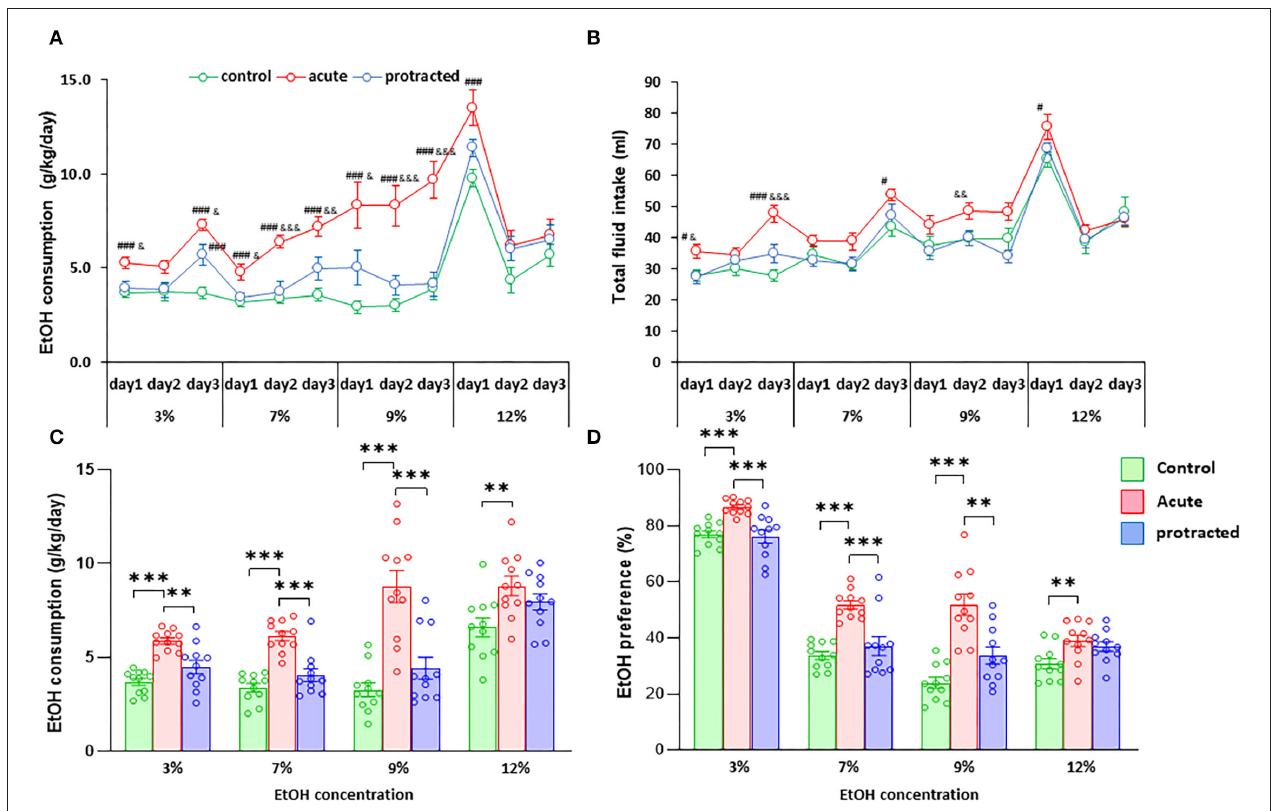
FIGURE 4 | Protracted and acute prenatal stress-evoked excessive ethanol intake in young adult female offspring at age of PND70. Ethanol drinking behavior was measured using two-bottle free-choice test. In (A,C) , a daily and means of 3-day ethanol consumption at given concentrations with corresponding control groups shows that male rats born from dams subjected to either protracted or acute stress developed significantly high ethanol consumption and preference (D) characterized by excessive ethanol intake (g/kg/day) to all four concentrations of ethanol provided and less water intake. * p < 0.05, ** p < 0.01, *** p < 0.001: Protracted, Acute vs. Control; # p < 0.05, ## p < 0.01, ### p < 0.001: Protracted, Acute vs. Control; & p < 0.05, && p < 0.01, &&& p < 0.001: Acute vs. Protracted. (B) Shows total fluid intake in three groups. 2-way repeated ANOVA, n = 11 for each group. Values are the mean ± SEM. Individual value is shown with circle dot on bar